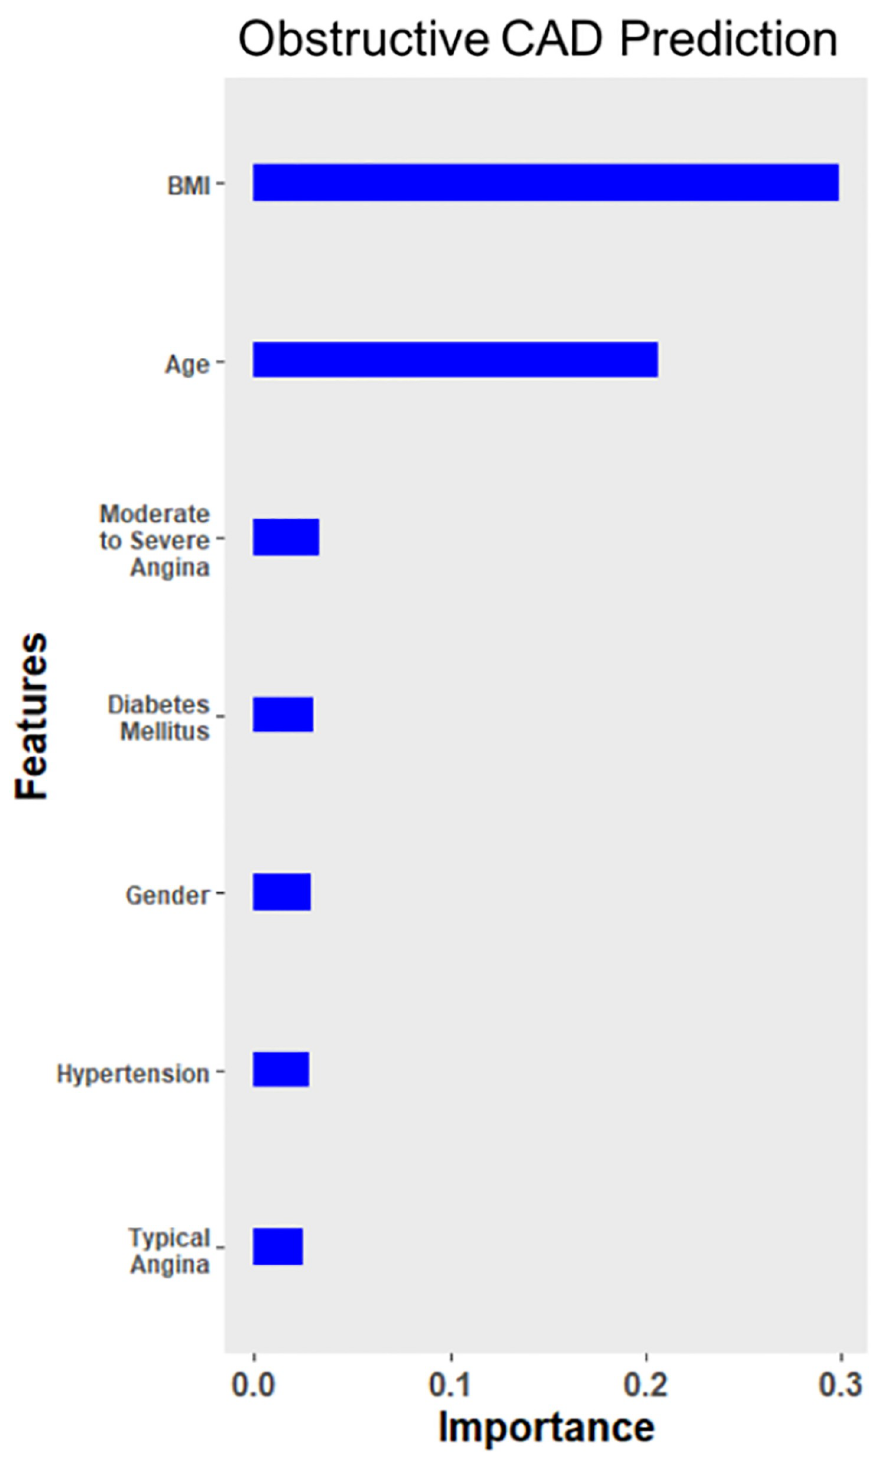
Fig 3. The relative importance of clinical variables in the developed machine learning–based model for the prediction of obstructive coronary artery disease. Abbreviations: BMI = body mass index, CAD = coronary artery